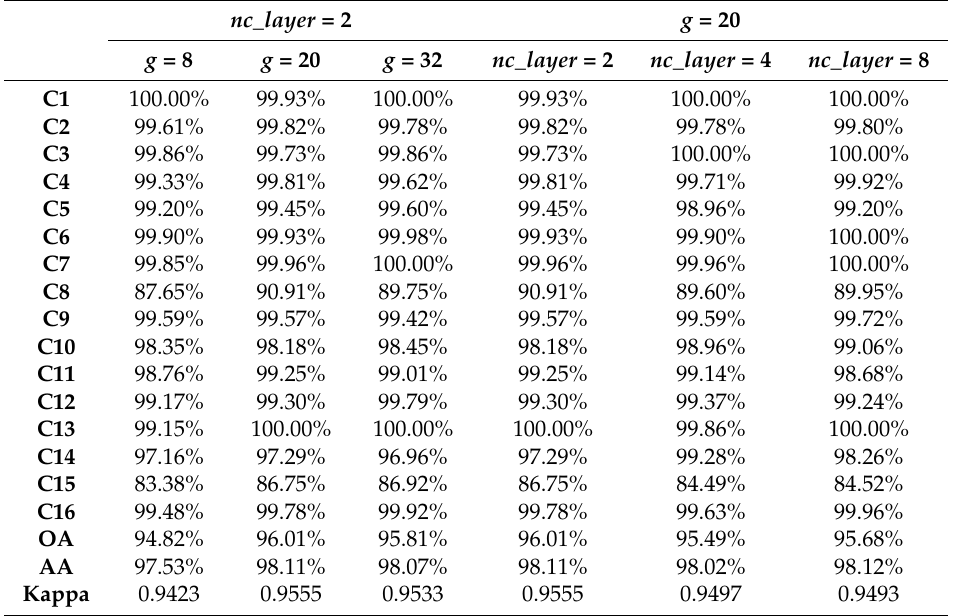
Table 5. Classification results under different width expansion rate or network depth in the Salinas dataset. nc_layer = 2 g =